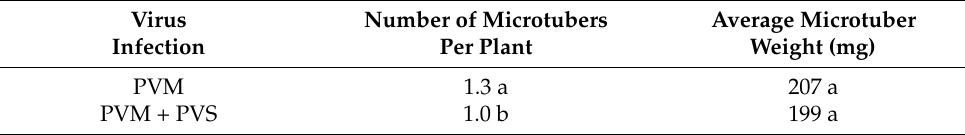
Table 3. Microtuber yield components, as affected by the sanitary status of the plants. Virus Number of Microtubers Average Microtuber Infection Per Plant Weight (mg) PVM 1.3 a 207 a PVM + PVS 1.0 b 199 a Values within the column followed by the same letter are not significantly different at p < 0.05.